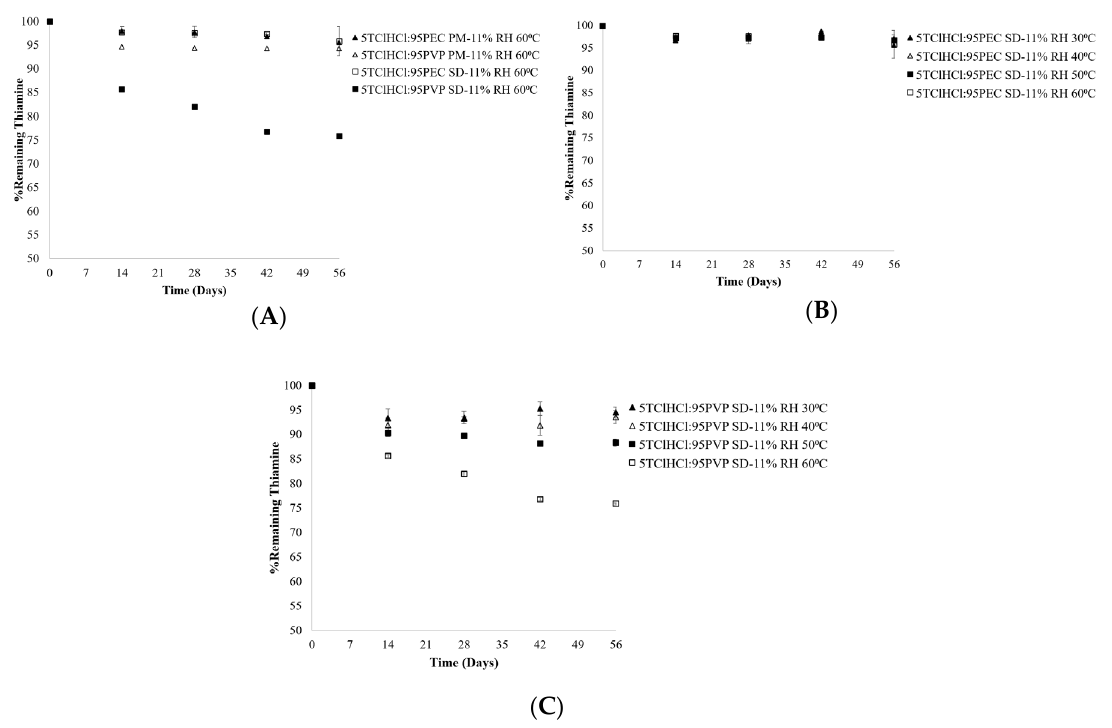
Figure 4. Chemical stability of thiamine in ( A ) 5TClHCl:95PEC and 5TClHCl:95PVP physical mixtures (PMs) compared to solid dispersions (SDs) stored at 11% RH and 60 ° C for 56 days, ( B ) 5TClHCl:95PEC solid dispersions (SDs) stored at 11% RH and 30–60 ° C for 56 days, and ( C ) 5TClHCl:95PVP solid dispersions (SDs) stored at 11% RH and 30–60 ° C for 56 days.